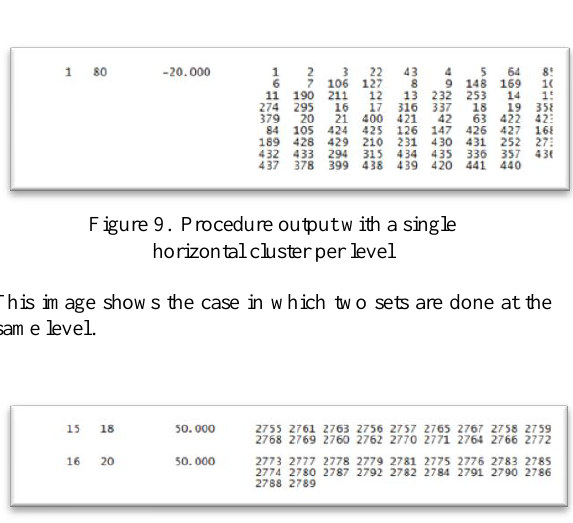
Figure 10. Procedure output with two horizontal clusters per